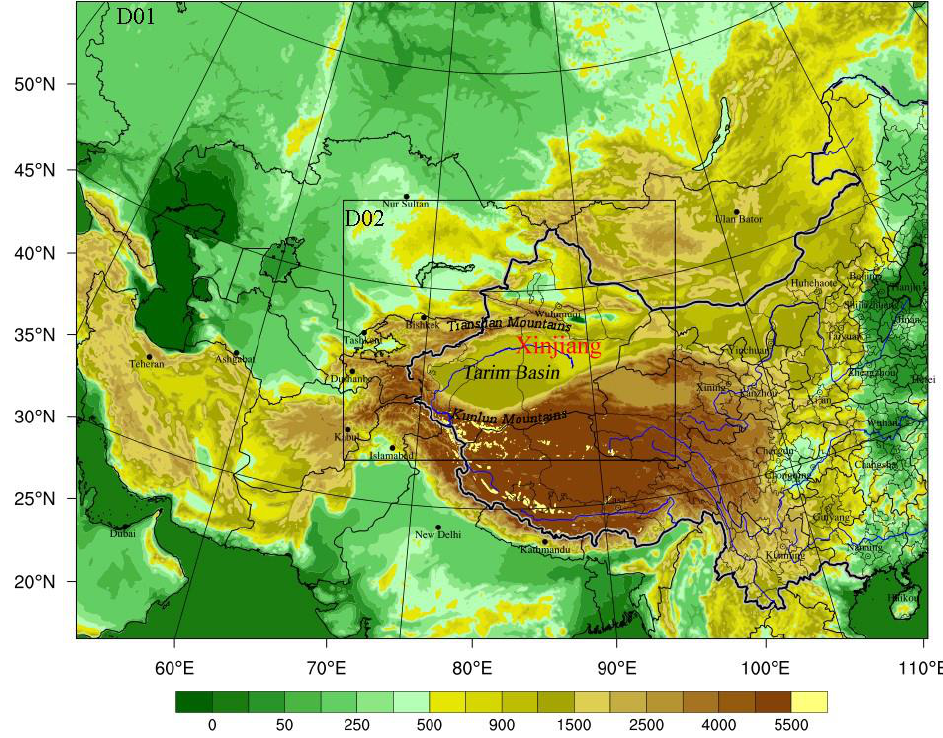
Figure 2. Two nested domains and topography.